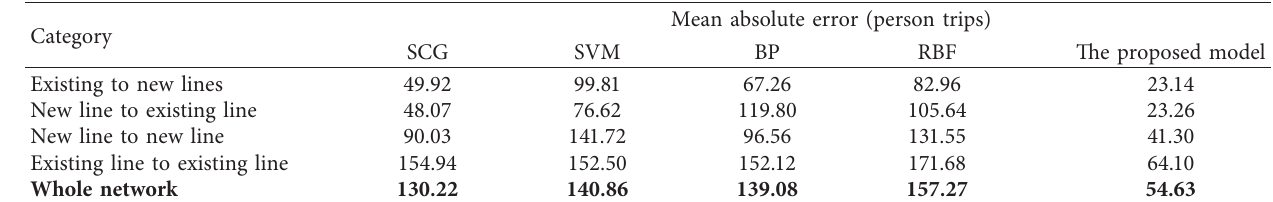
Table 7: Mean absolute error of prediction results.